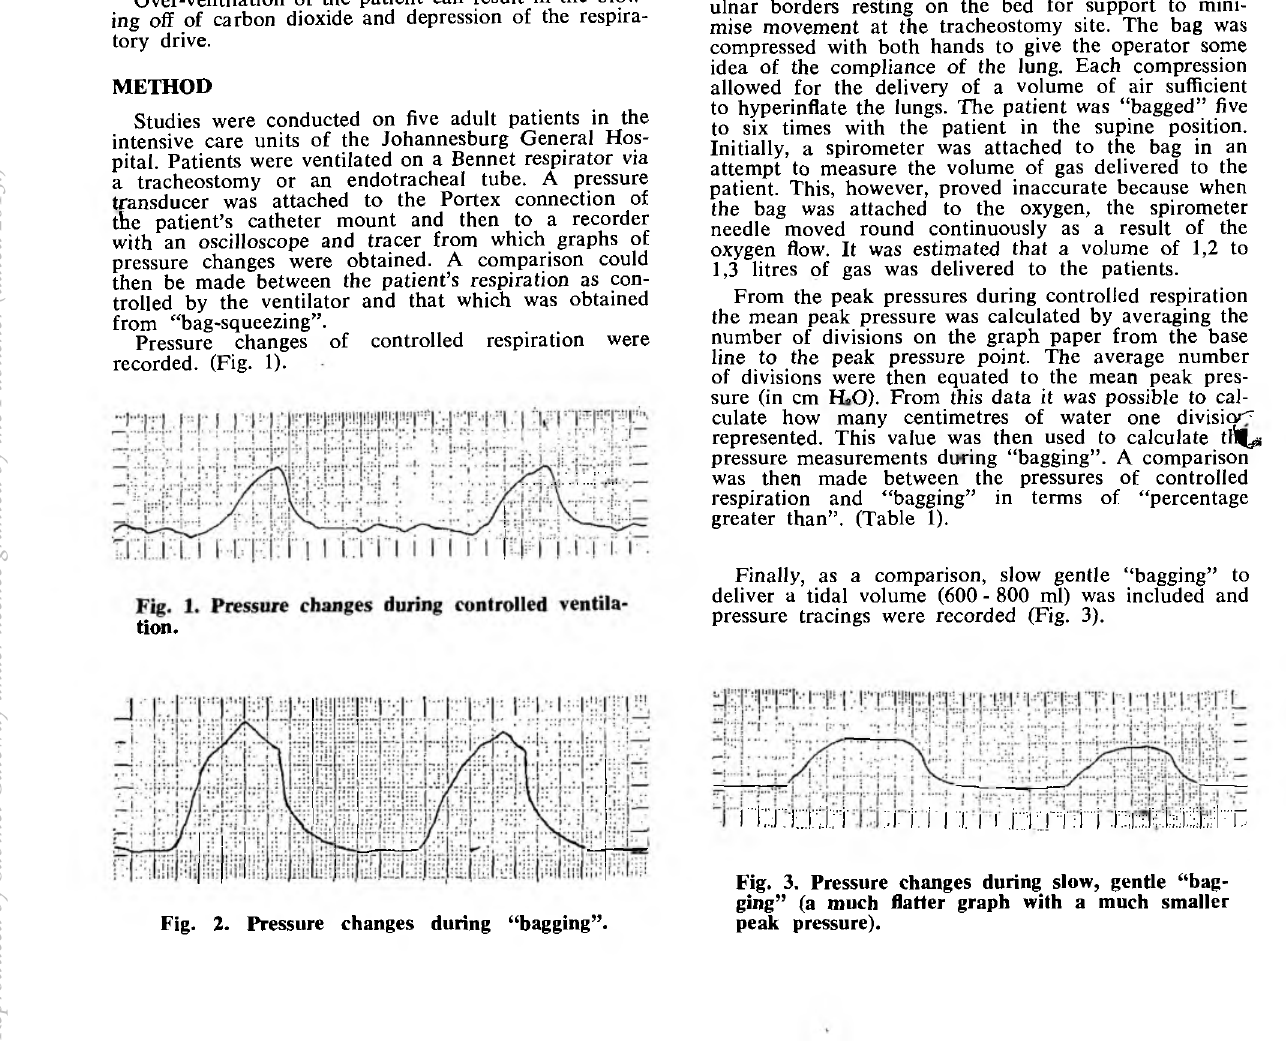
Fig. 3. Pressure changes during slow, gentle “bag­ ging” (a much flatter graph with a much smaller peak